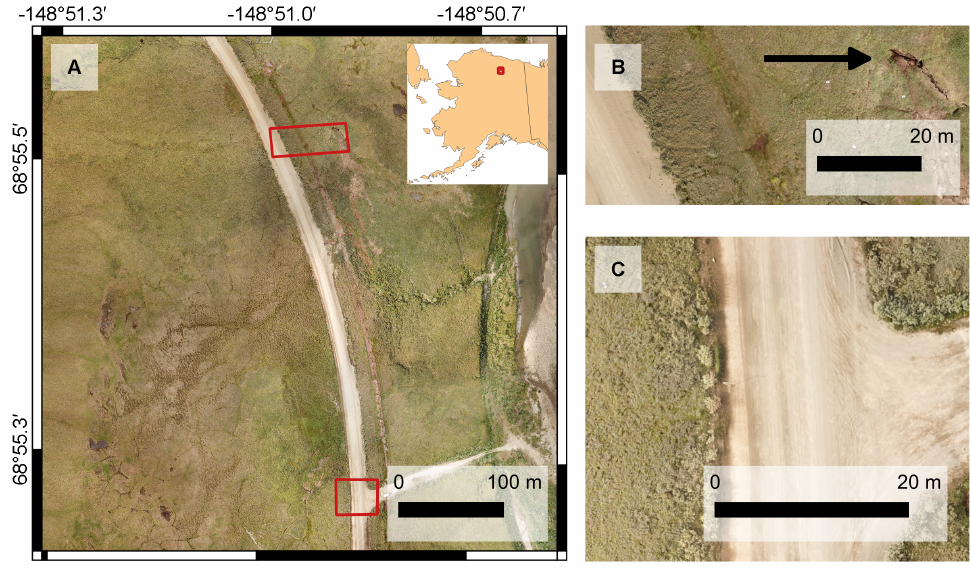
Figure 1. Map of the study area: ( A ) shows an orthophoto mosaic (RGB) of the study area along the Dalton Highway on the North Slope of Alaska. The subfigures on the right show the areas used for assessing the performance and accuracy of the workflow; ( B ) shows the area around an erosion feature assumed to undergo degradation; ( C ) depicts the road junction of the Dalton Highway, which is considered to be stable relative to the surrounding tundra. Raw images of the orthophoto mosaic were acquired on 18 July 2019, and stitched together using WebODM (see Section 2.3). The world border dataset for the inset map of Alaska in ( A ) is available from http://thematicmapping.org/ (accessed on 26 June 2021) and licensed under CC BY-SA 3.0 https://creativecommons.org/licenses/by-sa/3.0/ (accessed on 28 March 2022).